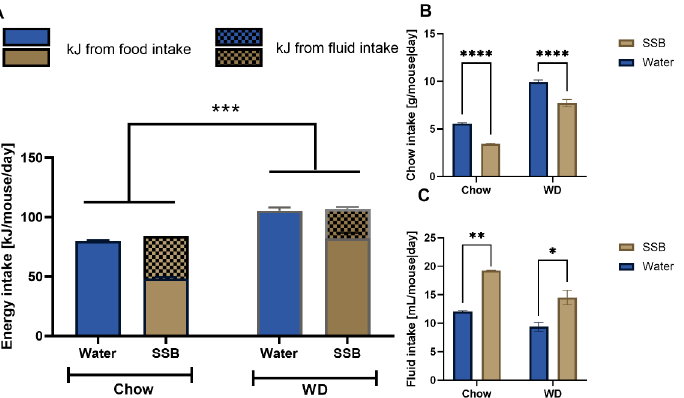
Figure 1. ( A ) Mean total energy intake ± SEM [kJ] from food (plain bars) and fluid intake (checkered bars) from mice receiving either a standard diet (chow) or Western-type diet (WD) with water (Water, blue bars) or a SSB (brown bars) as a drink. ( B ) Mean food intake ± SEM [g/mouse per day] and ( C ) mean fluid intake ± SEM [mL/mouse per day] from mice receiving either a standard diet